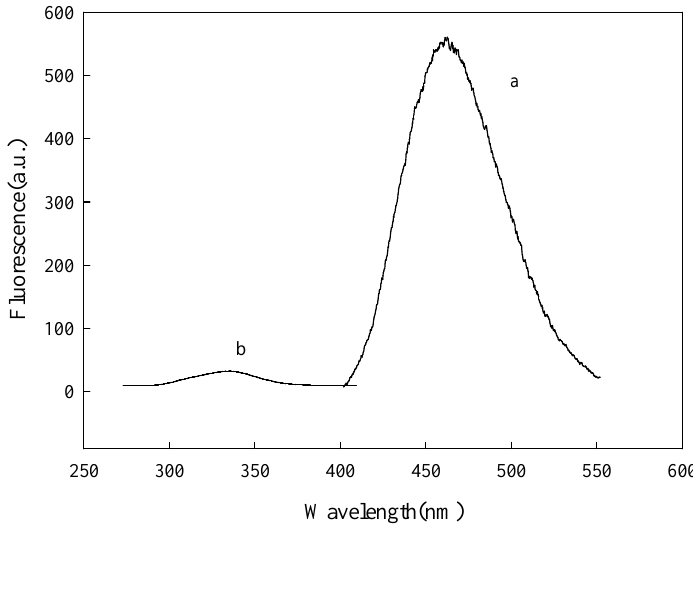
Figure 3. Fluorescence characteristics of TBG solution obtained by keeping the incubated immunocomposites (a) and the same immunocomposites without incubation (b) in a pH 5.8 B-R solution containing 3 · 10 -5 mol/L TBG in the presence of 5 · 10 -4 mol/L H min. Before this procedure, the renewed immunocomposite surface was subjected to a 30 min-incubation in a pH 5.8 B-R solution containing 5 · 10 -6 g/L